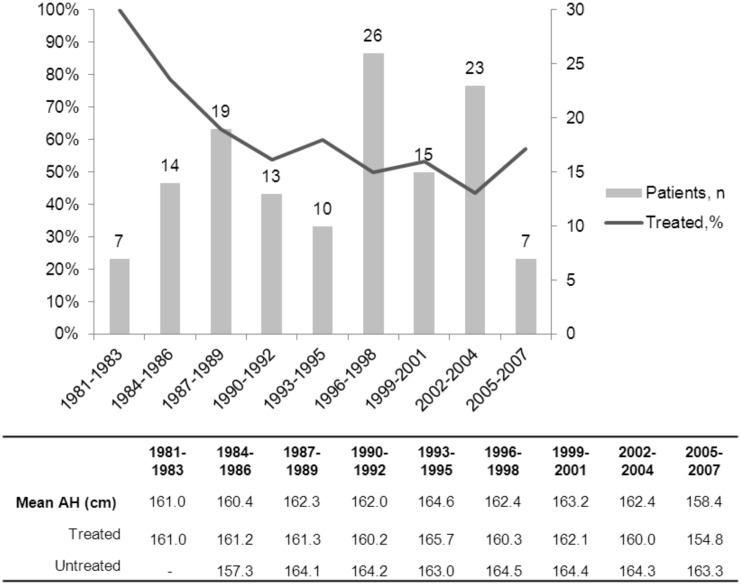
Evolution of consultations and treated girls rates over 26 years in the 134 girls with CPP of the present study.Plain line represents the average of the proportion of treated girls over 7 years (current year, 3 years before and 3 years after).